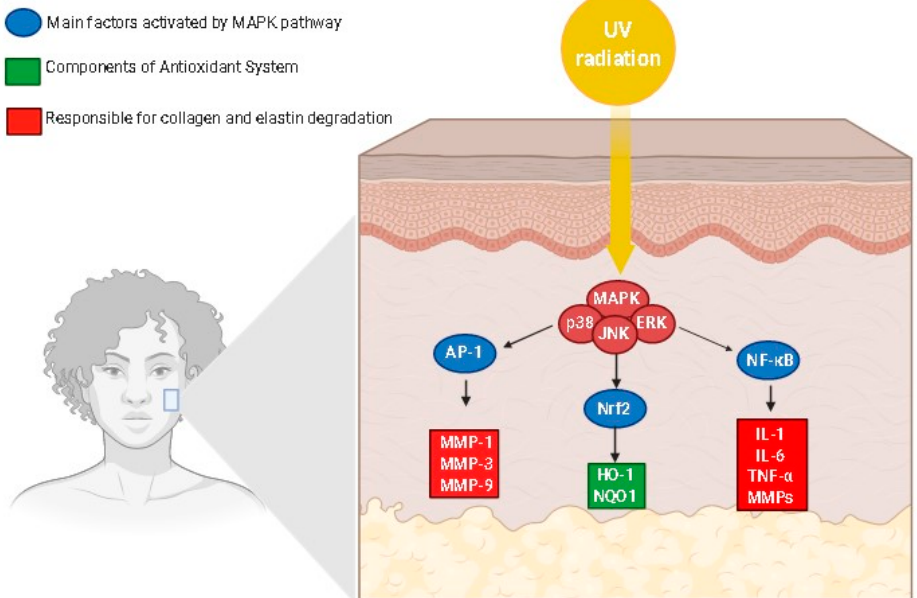
Figure 6. Mitogen-activated protein kinase signaling pathway modulating mediators of the skin aging process. AP-1, activator protein 1; Nrf2, nuclear factor (erythroid-derived 2)-like 2; NF- κ B, Nuclear factor-kappa B; MMP, metalloproteinases; NQO11, NADPH-quinone oxidoreductase 1; HO-1, heme oxygenase-1. The illustration was drawn using Biorender software. The MAPK pathway may trigger Nrf2 activation (Figure 6) [36,38,50]. UVB